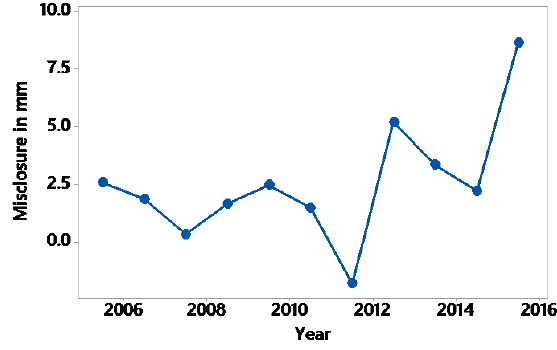
Fig. 3. Year by year GMSL budget misclosures in